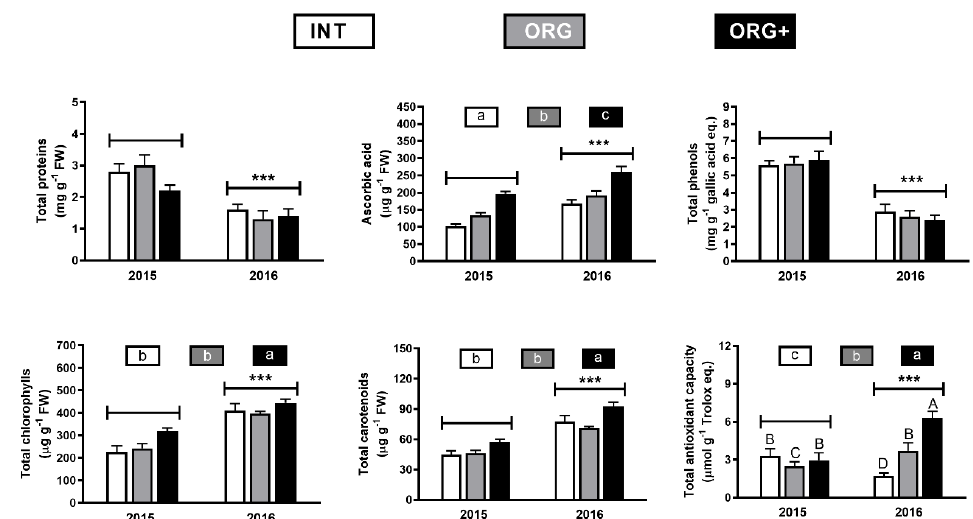
Figure 1. Total proteins, ascorbic acid, total phenols, total chlorophylls, total carotenoids, and total antioxidant activity of spring lettuce cultivated according to three di ff erent cropping system: integrated (INT), organic farming (ORG), and organic no-tillage (ORG + ) in a two-year experiment. Each value is the mean ± SD of three replicates. Means keyed with the same capital letter are not significantly di ff erent for p = 0.05 following two-way ANOVA using production year (2015–2016) and the three di ff erent cropping systems (INT, ORG, and ORG + ) as the variability factors. When the F ratio in the two-way ANOVA interaction was not found significant, data were analyzed by one-way ANOVA using year of cultivation or cultivation systems (considering the average of two years of production) as the variability factor. The presence of asterisks denotes significant di ff erences for p < 0.05 following one-way ANOVA using production year as the variability factor (*** p < 0.001), whilst the presence of di ff erent lowercase letters denotes significant di ff erences for p < 0.05 following one-way ANOVA using cropping systems as the variability